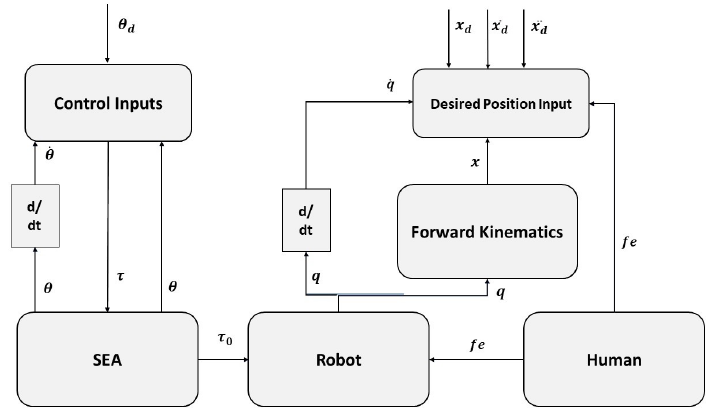
Figure 6. Controller layout for SEA robots.